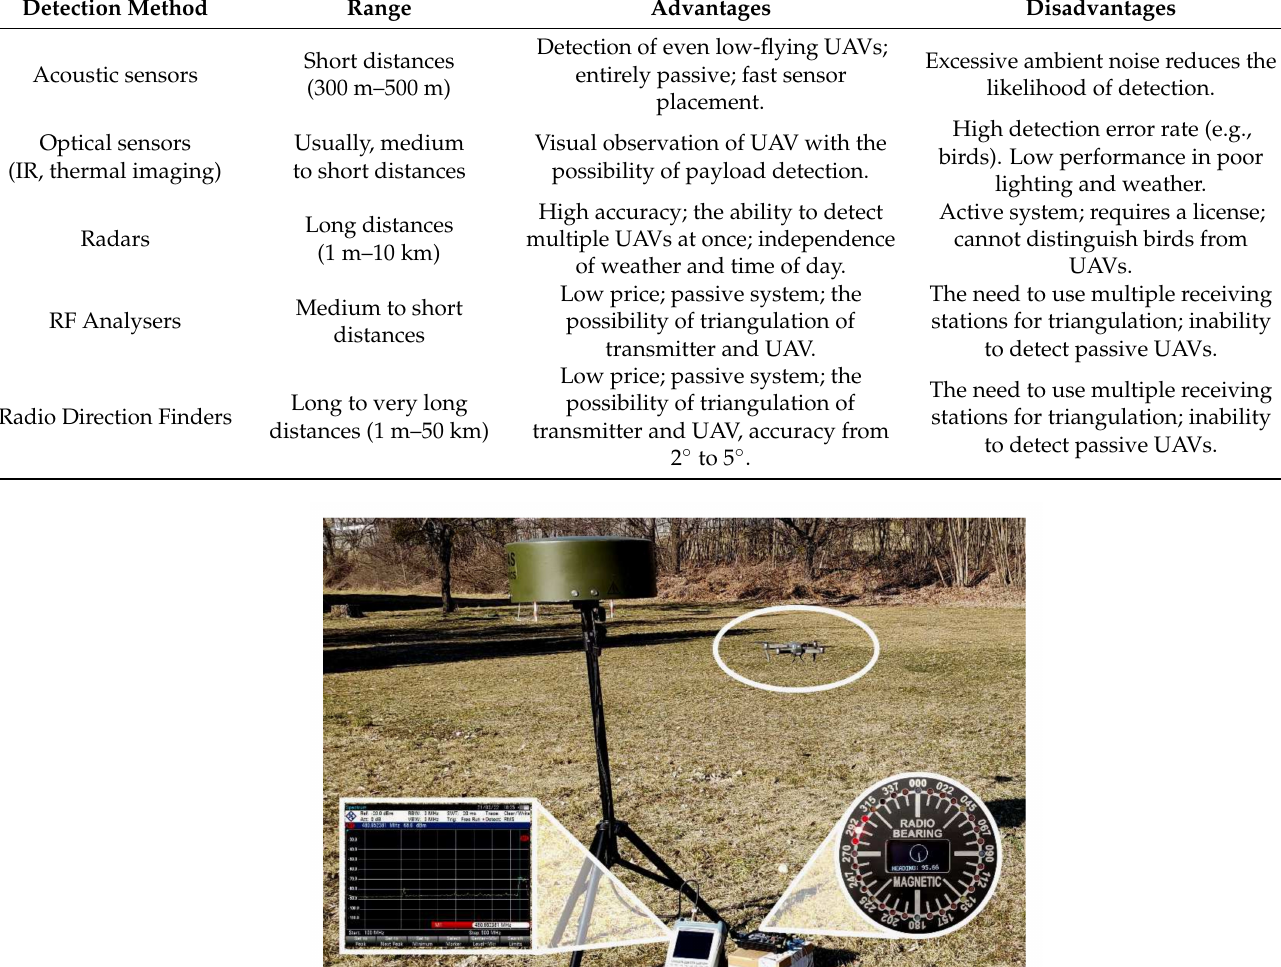
Table 1. Counter drone detection methods.